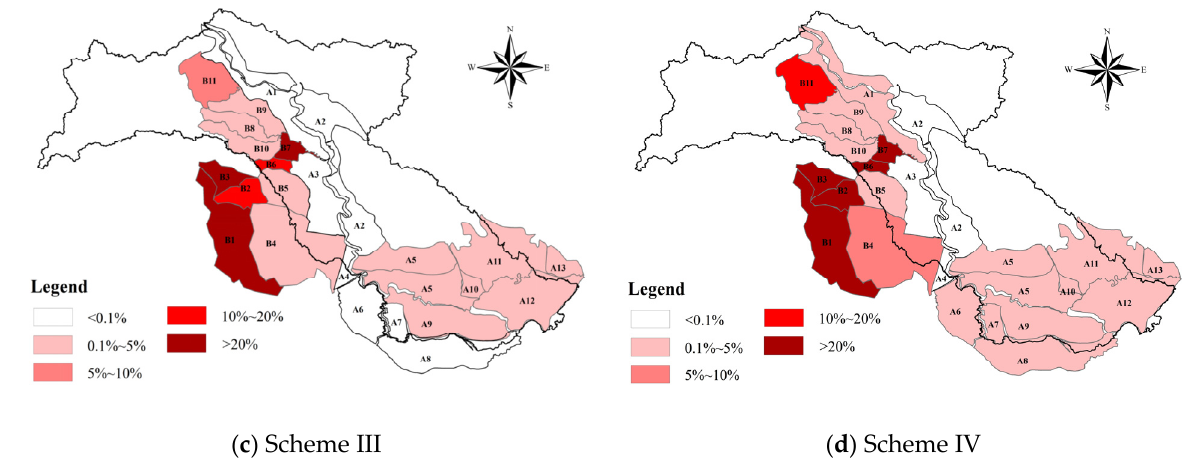
Figure 8. Spatial distribution of water deficit rates in operational zones under the schemes ( a ) I, ( b ) II, ( c ) III and ( d ) IV.